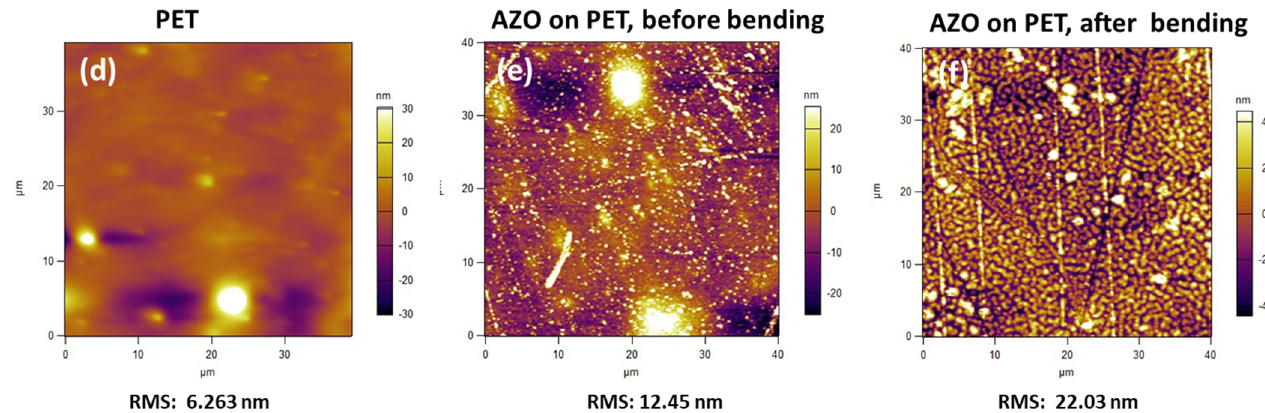
Figure 3. AFM images: ( a – c ) AZO on mica (as-deposited and after bending) and blank mica and ( d – f ) AZO on PET (as-deposited and after bending test) and blank PET, respectively.